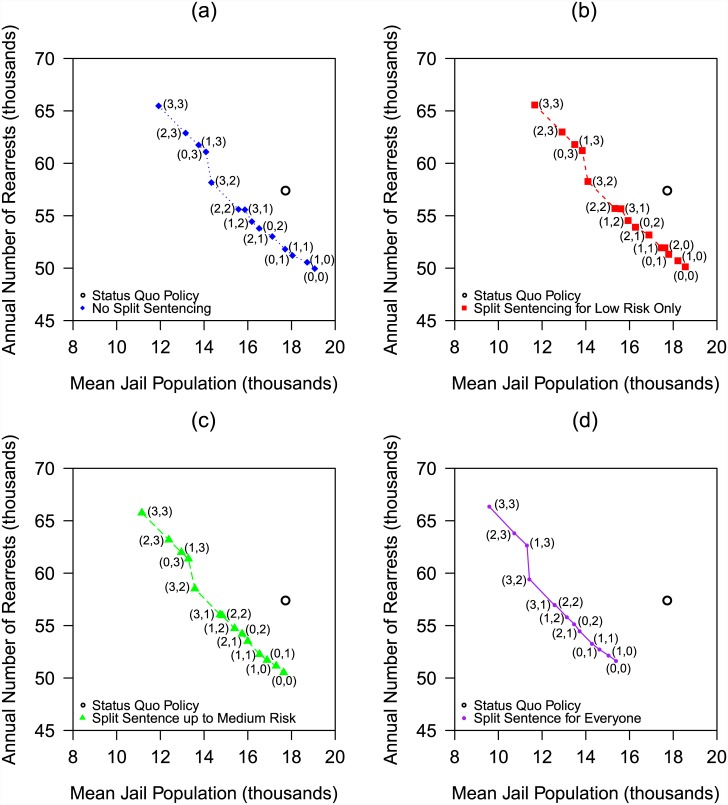
For each of the four tradeoff curves in Fig 2a, the optimal policy along the different points on the curve.Each policy is denoted by a pair of numbers, where the first number corresponds to the pretrial release for non-felonies (left column of Table 1) and the second number corresponds to the pretrial release for felonies (middle column of Table 1).